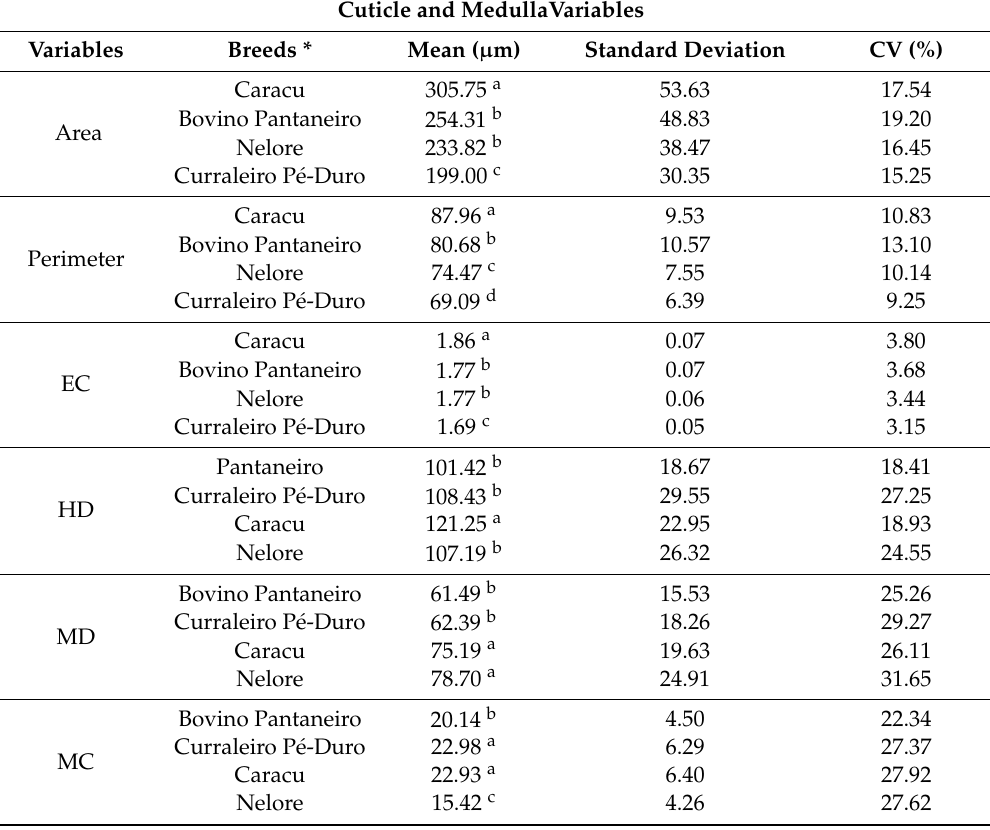
Table 2. Analysis of variance and comparison test of the means of the parameters of cattle hairs of Bovino Pantaneiro, Curraleiro P é -Duro, Caracu, and Nelore. Cuticle and MedullaVariables Variables